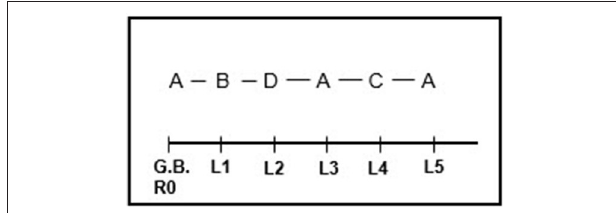
FIGURE 3 | Optimized corrected behavioral pattern following construction of a confidence interval around the unconditional probabilities. The corrected pattern reveals the typical alternation seen in patients with endogenous depression.